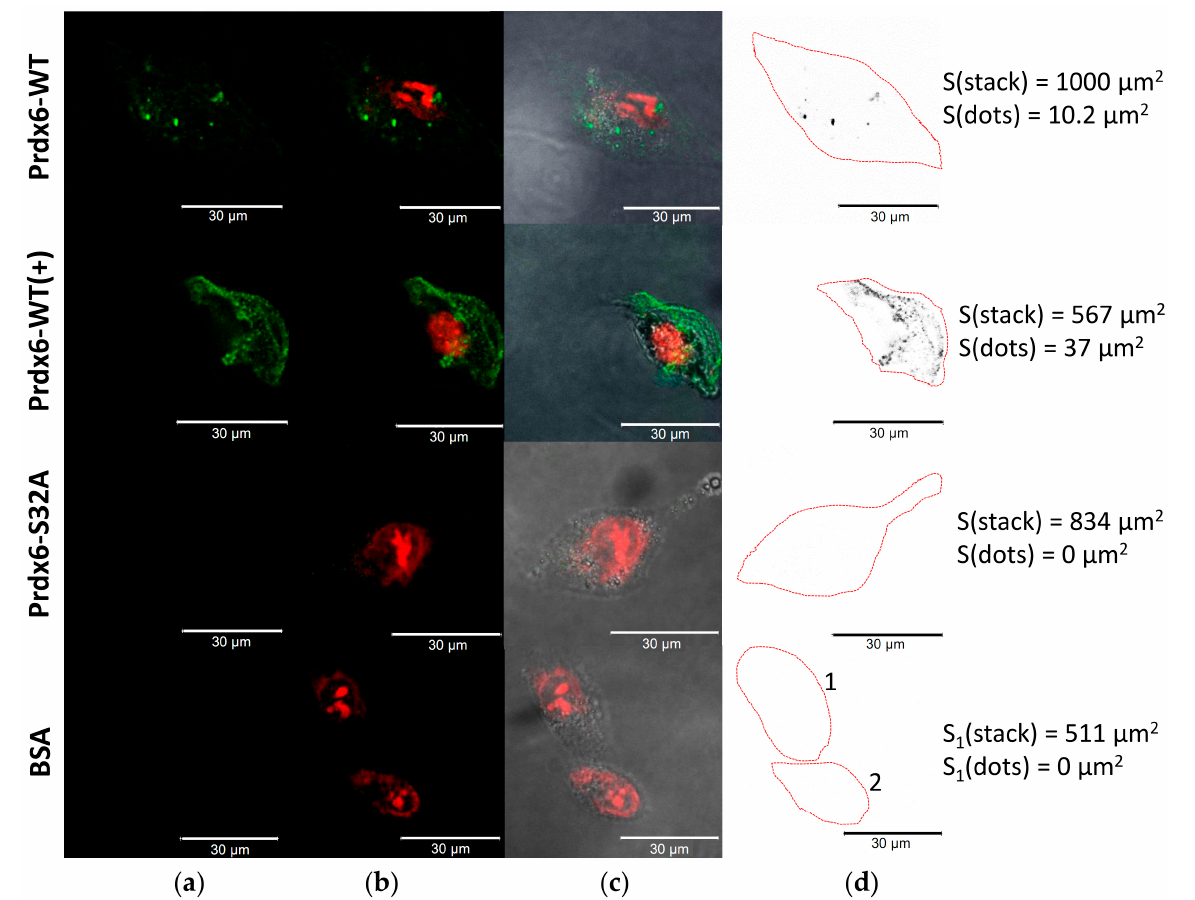
Figure 6. Penetration of exogenous Prdx6 (WT and S32A) into A549 cells. ( a ) FAM channel (green) corresponds to FITC-labeled proteins; ( b ) Texas Red channel (red) is aligned with the FAM channel and marks ethidium bromide-stained genomic DNA; ( c ) superimposition of FAM + Texas Red + phase contrast; ( d ) the number of cells in the field of view and areas analyzed in ImageJ are marked, cell contours are shown in red, stack areas and areas with labeled proteins (dots, int–inside the cells, ext–on the cell surface) are shown for the corresponding cells. Scale bars are 30 μ m.